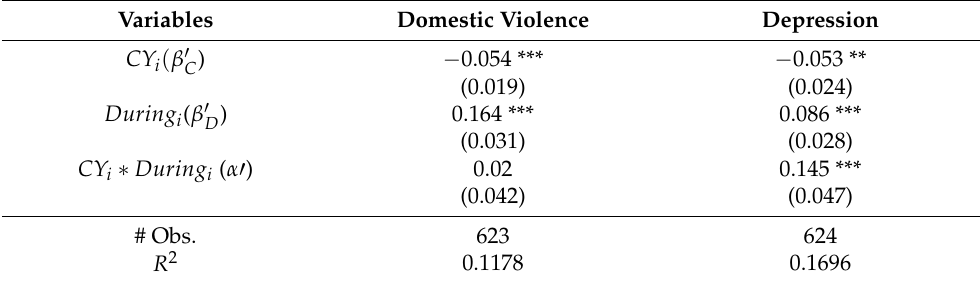
Table 2. Estimate to the key coefficients in DID regression Equation (2). Variables Domestic